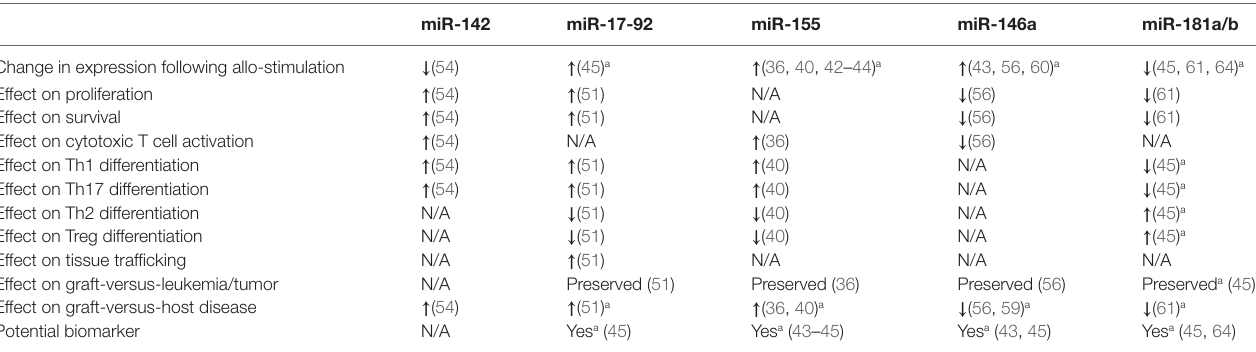
TAbLe 1 | Influence of microRNA (miRNAs) on allogeneic T